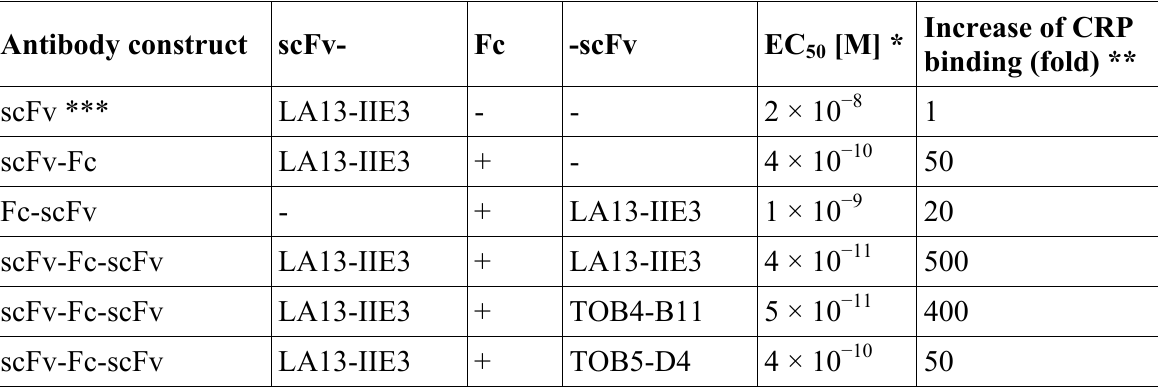
Table 2. Antigen binding of CRP-specific mono-, bi- and tetravalent antibody constructs. Antibody